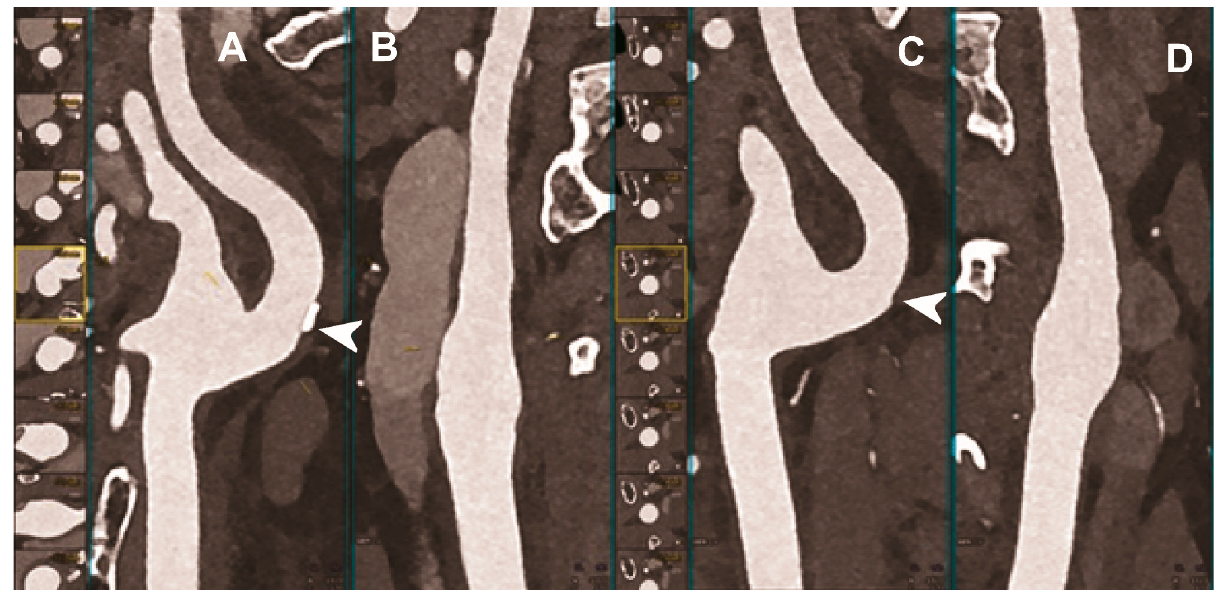
Figure 4. Carotid CT angiography using photon-counting computed tomography. The figure shows advanced reconstructions of a carotid artery tree derived from a photon-counting CT (Scanner: NAEOTOM Alpha, Siemens) acquisition ( A – D ). In ( A , B ), a longitudinal multiplanar reconstruction shows the right common and internal carotid artery with no significant luminal stenosis and a mild predominantly calcified atherosclerotic plaque at the internal carotid origin (arrowhead). In ( C , D ), a longitudinal multiplanar reconstruction shows the left common and internal carotid artery with a minimal arterial wall irregularity at the internal carotid origin (arrowhead). What is a bit unusual is to be able to see the thickness of the arterial wall at this level in a case with very mild atherosclerotic disease.